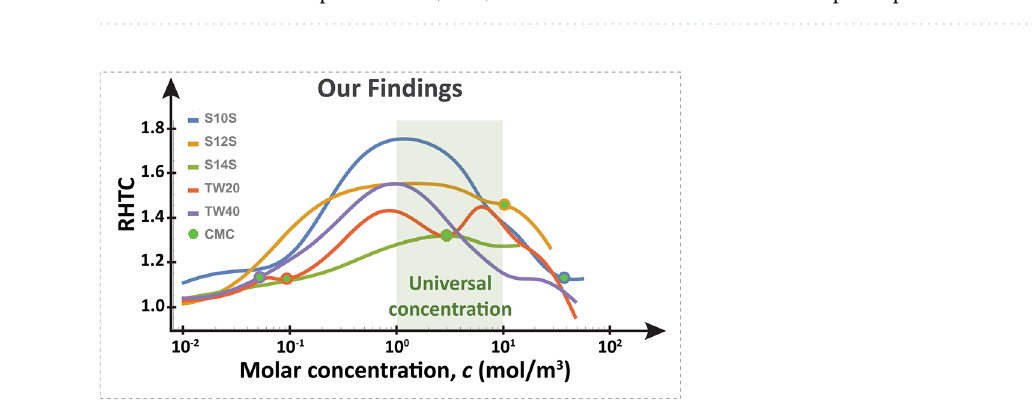
Figure 3. According to previous studies, the optimal boiling performance should be in concentration ranges near each surfactant’s respective CMC; thus, each surfactant should have its own separate peak in RHTC.